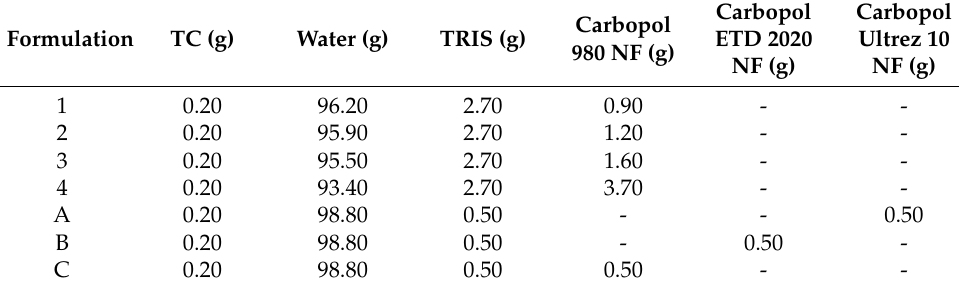
Table 2. Composition of the studied hydrogel preparations.